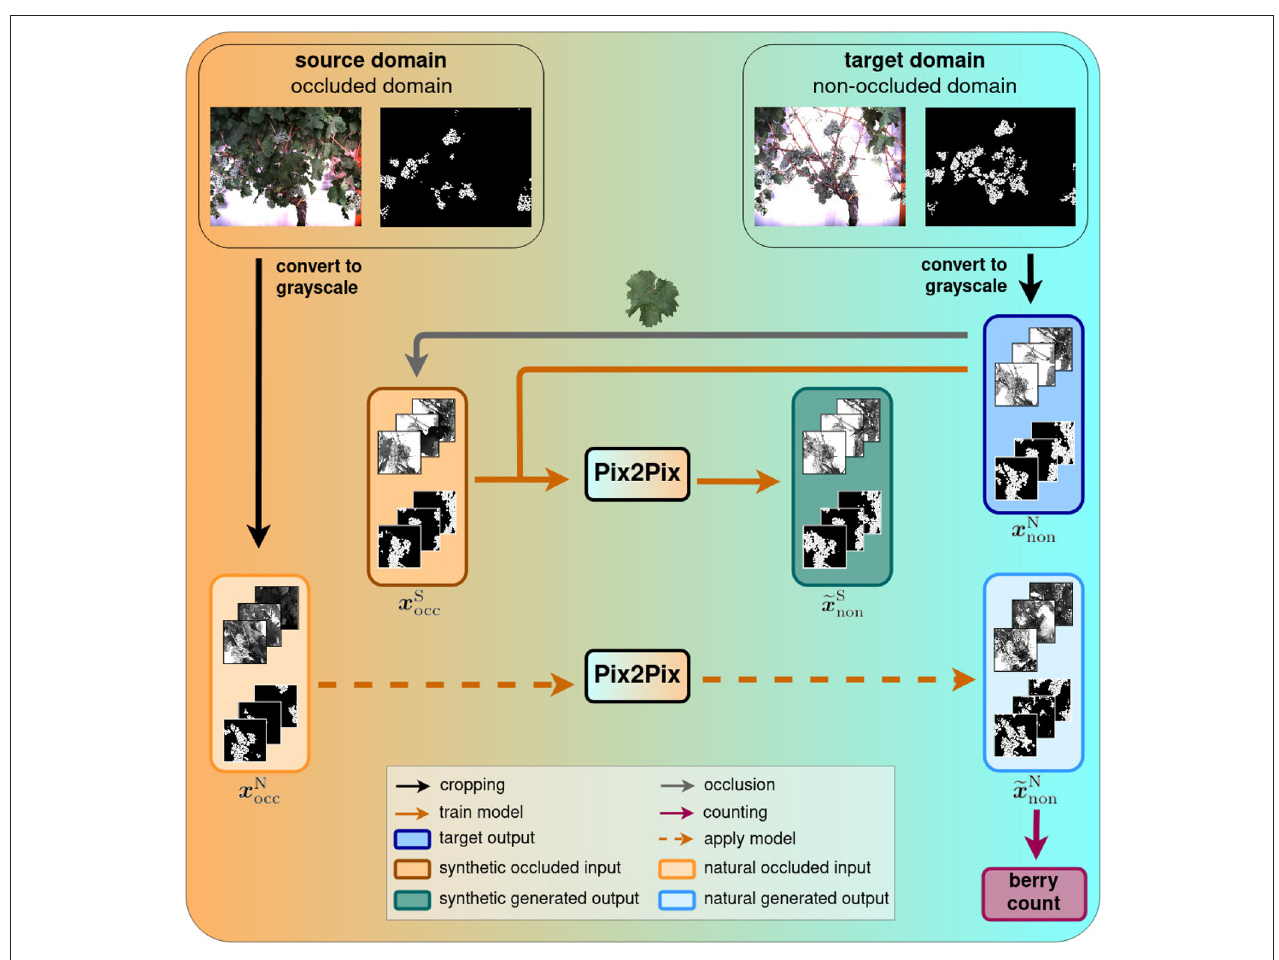
FIGURE 1 | Domain-transfer framework. We transfer images from the source domain with occluded berries to the target domain with revealed berries using the Pix2Pix cGAN. We train and test the model on synthetic data and subsequently apply it to natural data. Finally, a berry counting is performed on the generated outputs. Further evaluation steps will be performed in our experiments.